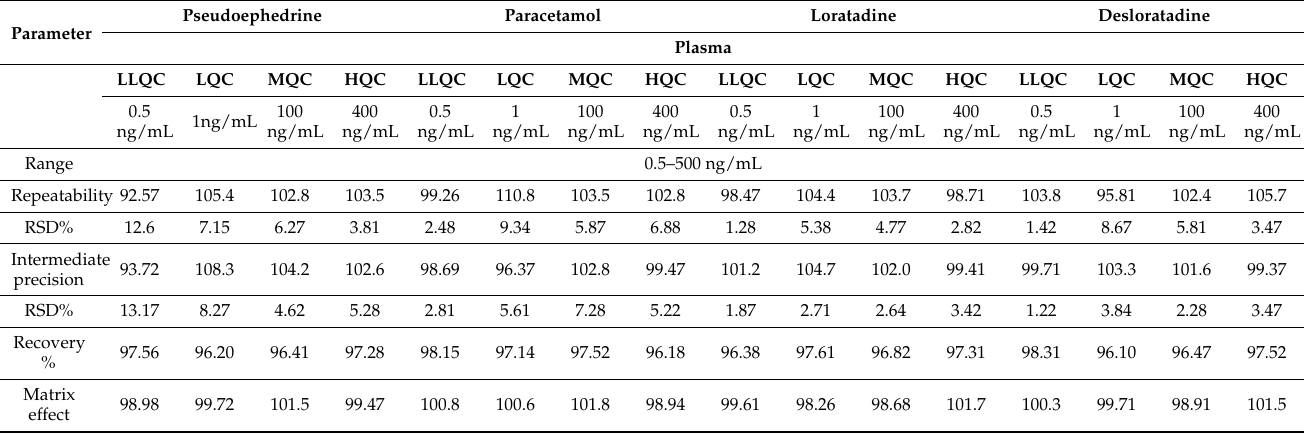
Table 4. Validation parameters of the SPE-HPC-MS method in plasma